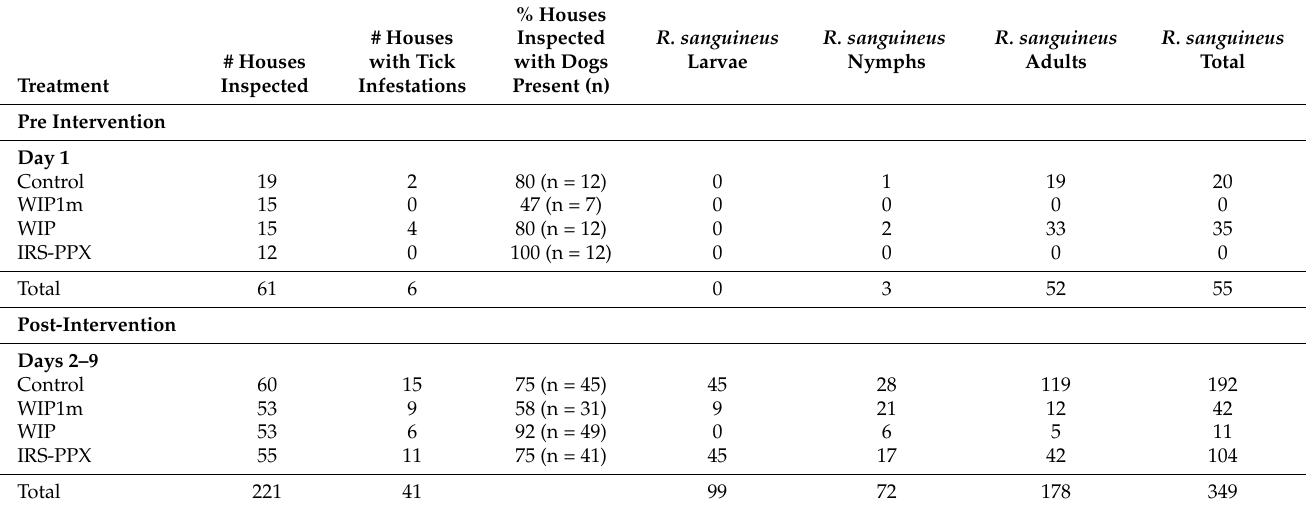
Table 1. Rhipicephalus sanguineus ticks collected from walls during home inspections by treatment (pre and post intervention) for the study period, 2018–2019; n= number of houses with dogs present during inspection.